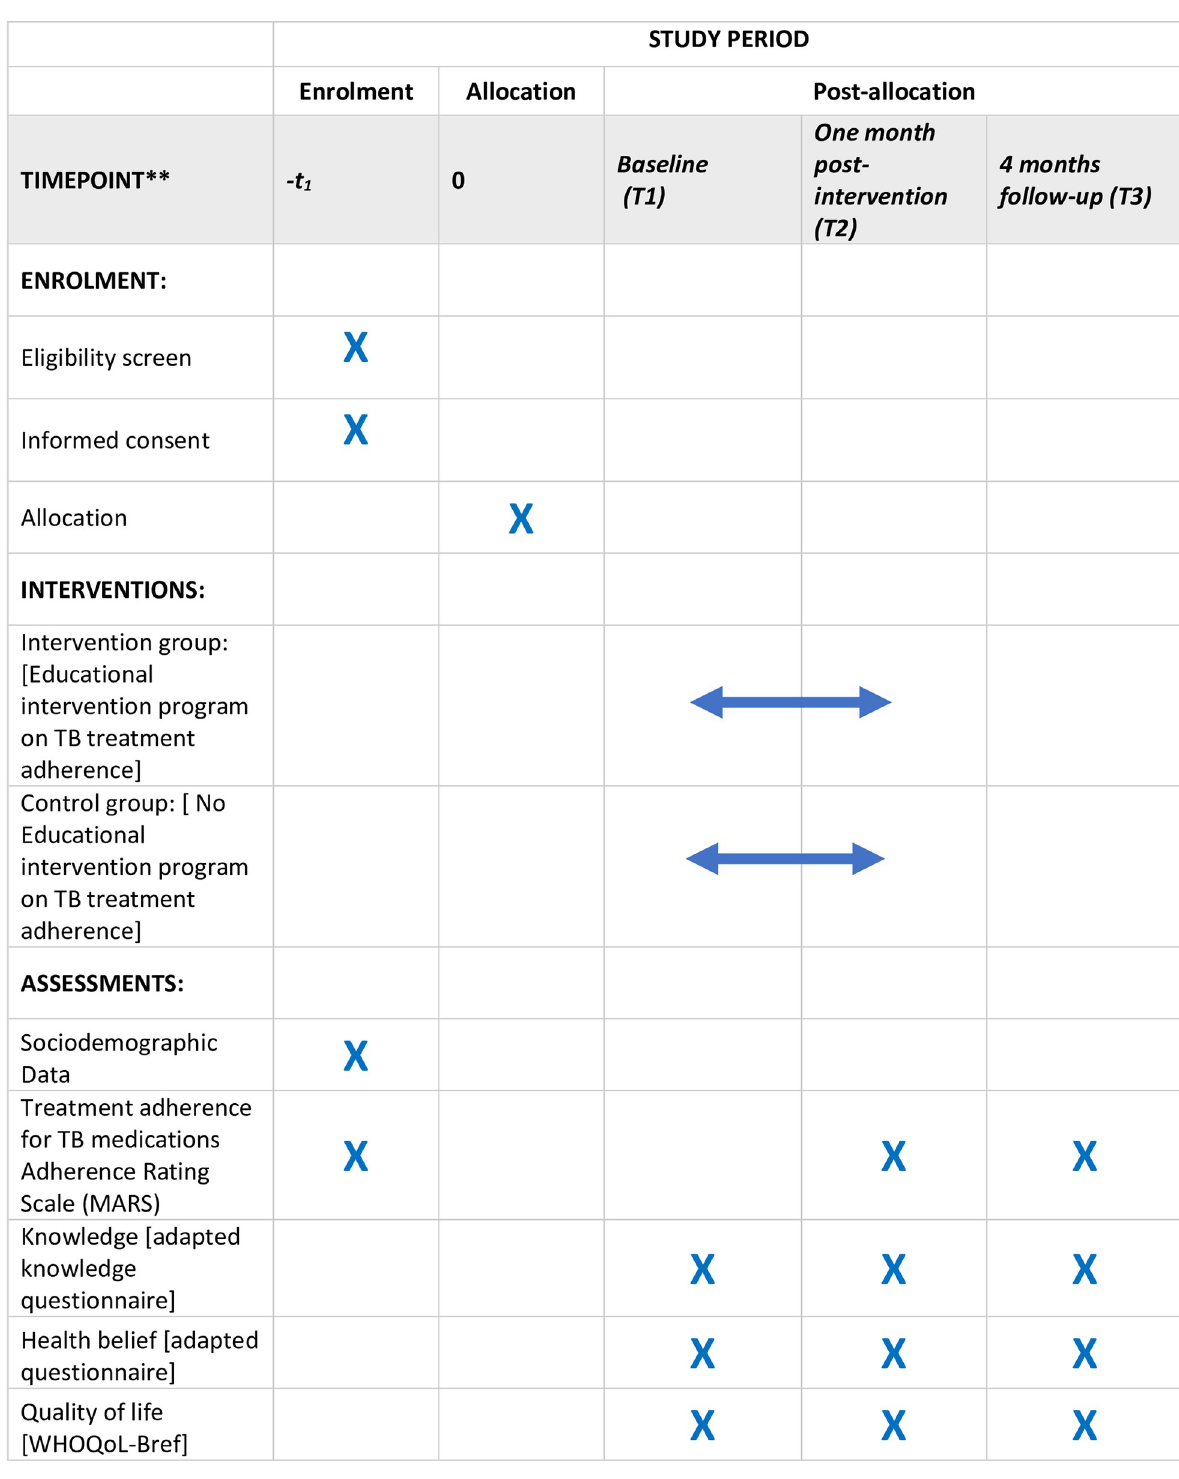
Fig 1. SPIRIT schedule of enrolment, interventions, and assessments [21].